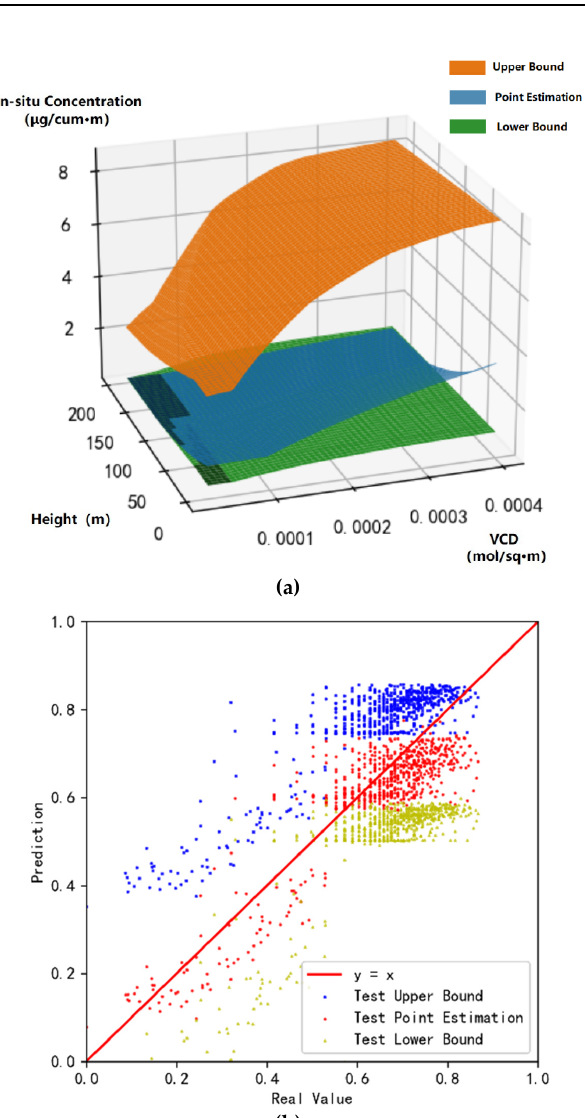
Figure 8. ( a ) The estimated upper bound, point estimation and lower bound (90% CI) as a function of the height and vertical column density of HCHO when the altitude is fixed at 0 m, where CI represents confidence level. The results in this figure were obtained by feeding the equally spaced mock data into the two models. ( b ) The comparison of the models’ estimation and the real value in the validation set. Taken logarithm and standardized to 0–1 for proper visualization. Confidence level, together with covering length, lay the foundation for the trustwor- thiness and precision of our interval prediction. As shown in Table 4, the interval estima- tion model obtained the covering rates and the ratio of true values covered by the pre- dicted interval of 94.41% and 88.74%, exceeding the pre-set confidence levels of 𝛼 = 0.9 and 𝛼 = 0.8 , respectively. In addition, as expected in Section 2.2.3, a higher confidence level yielded a longer average interval length (Interval length = Upper Bound–Lower Bound), which was 4.530 μ g /m 3 for 𝛼 = 0.9 , 17% more than 3.864 μ g /m 3 for 𝛼 = 0.8 . Such a phenomenon can also